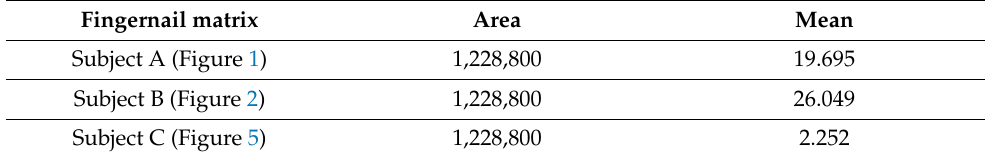
Figure 6. Immunoperoxidase staining for Sheep Anti-Morphine in the fingernail of Subject C, 10 × magnification. The pictures show an absence of positivity for morphine in the nail matrix cells. Counterstaining with hematoxylin. Primary Ab: Polyclonal anti-Morphine Antibody produced in Sheep, dil. 1:100. Secondary Ab: Monoclonal Anti-Goat/Sheep IgG-Peroxidase Antibody produced in Mouse, dil. 1:100, original magnification: 10 × . Table 3. ImageJ Fiji DAB intensity